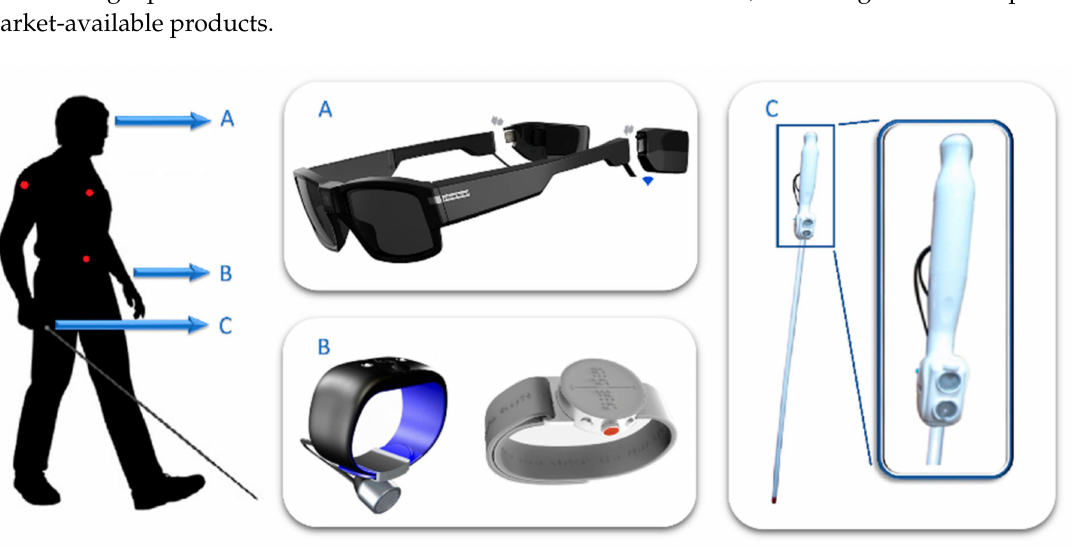
Figure 7. Wearables for the BVI: common